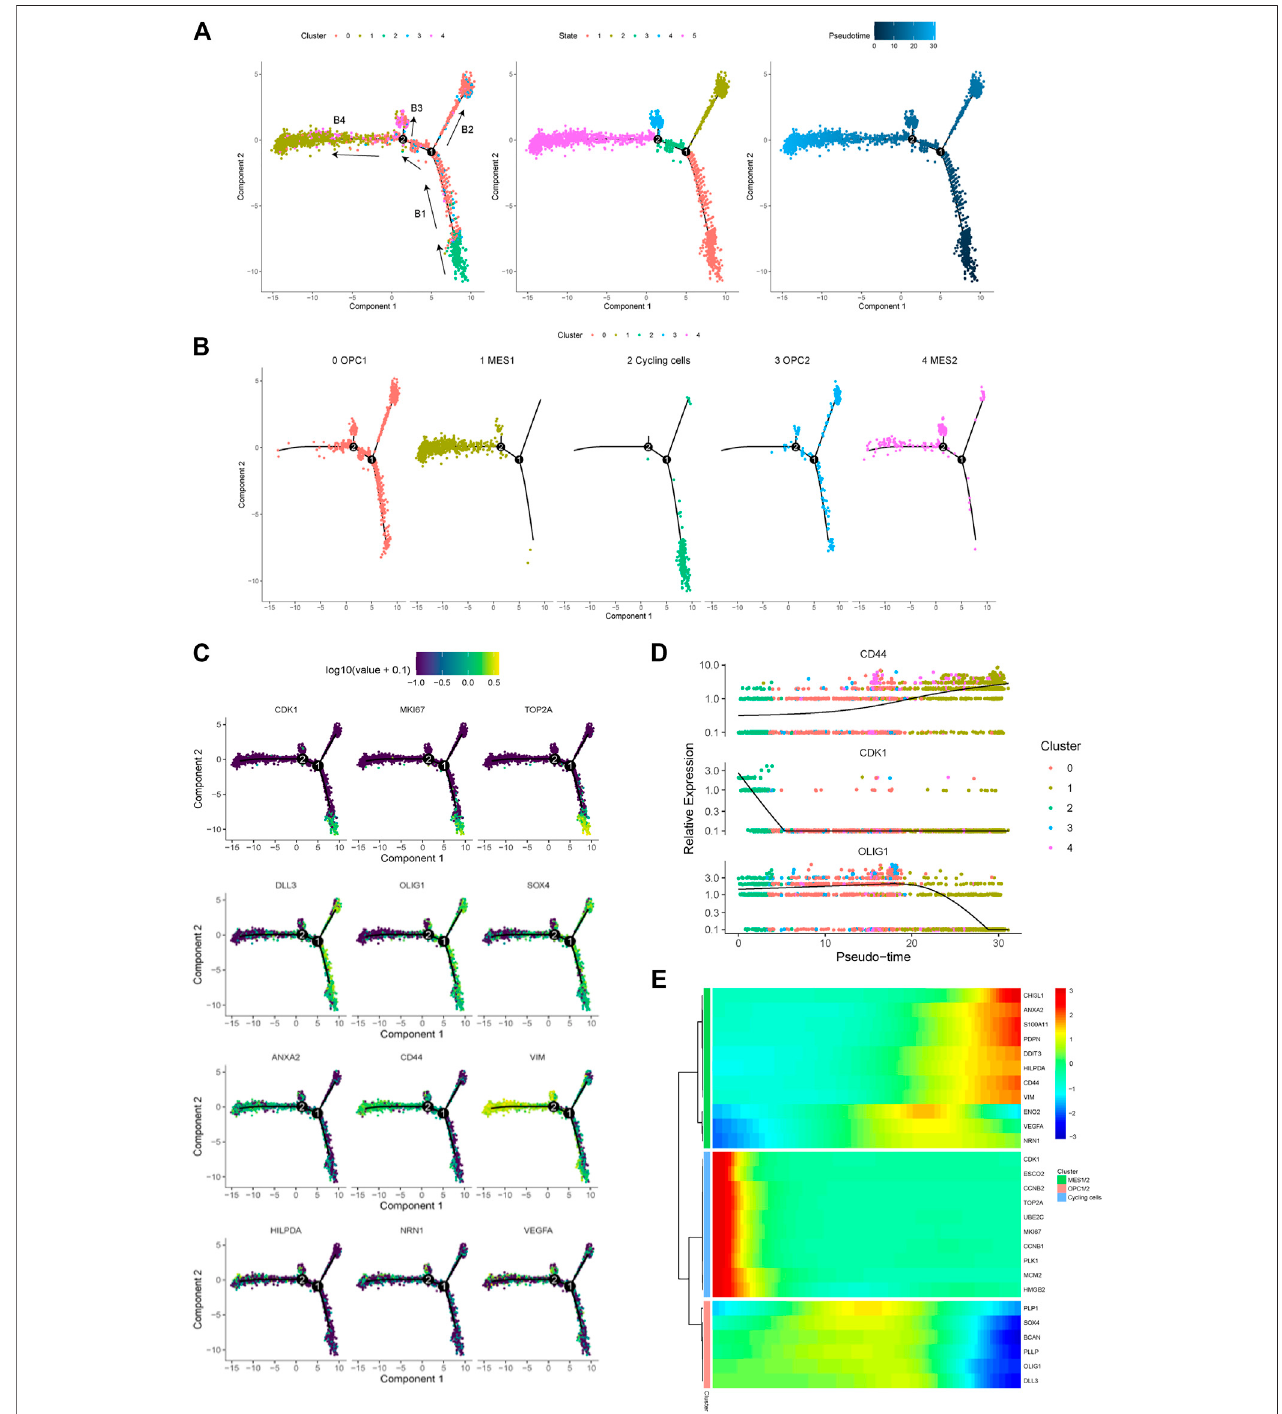
FIGURE4| Trajectory analysisofcancer cells inaglioma. (A) Pseudotimetrajectoryanalysisrevealed four branches(B1, B2, B3and B4)ofcancercell evolution in this glioma. Cancer cells plotted on the trajectory were colored by clusters (left), states (middle) and pseudotime (right). Black arrows indicatedthe direction of evolution. (B) The location of fi ve cancer cell subpopulations projected on the trajectory. (C) The expression of representative markers of cycling cells (CDK1, MKI67 and TOP2A), OPC/NPC-like cells (DLL3, OLIG1 and SOX4), and MES-like cells (ANXA2, CD44, VIM, HILPDA, NRN1 and VEGFA) plotted on the trajectory. (D) The relative expressionlevelsoftheCD44,CDK1andOLIG1genesspanningcycling,OPC/NPC-liketoMES-likecellsoverpseudotime. (E) Heatmapofthetopupregulatedgenesin cycling, OPC/NPC-like and MES-like cells over pseudotime.